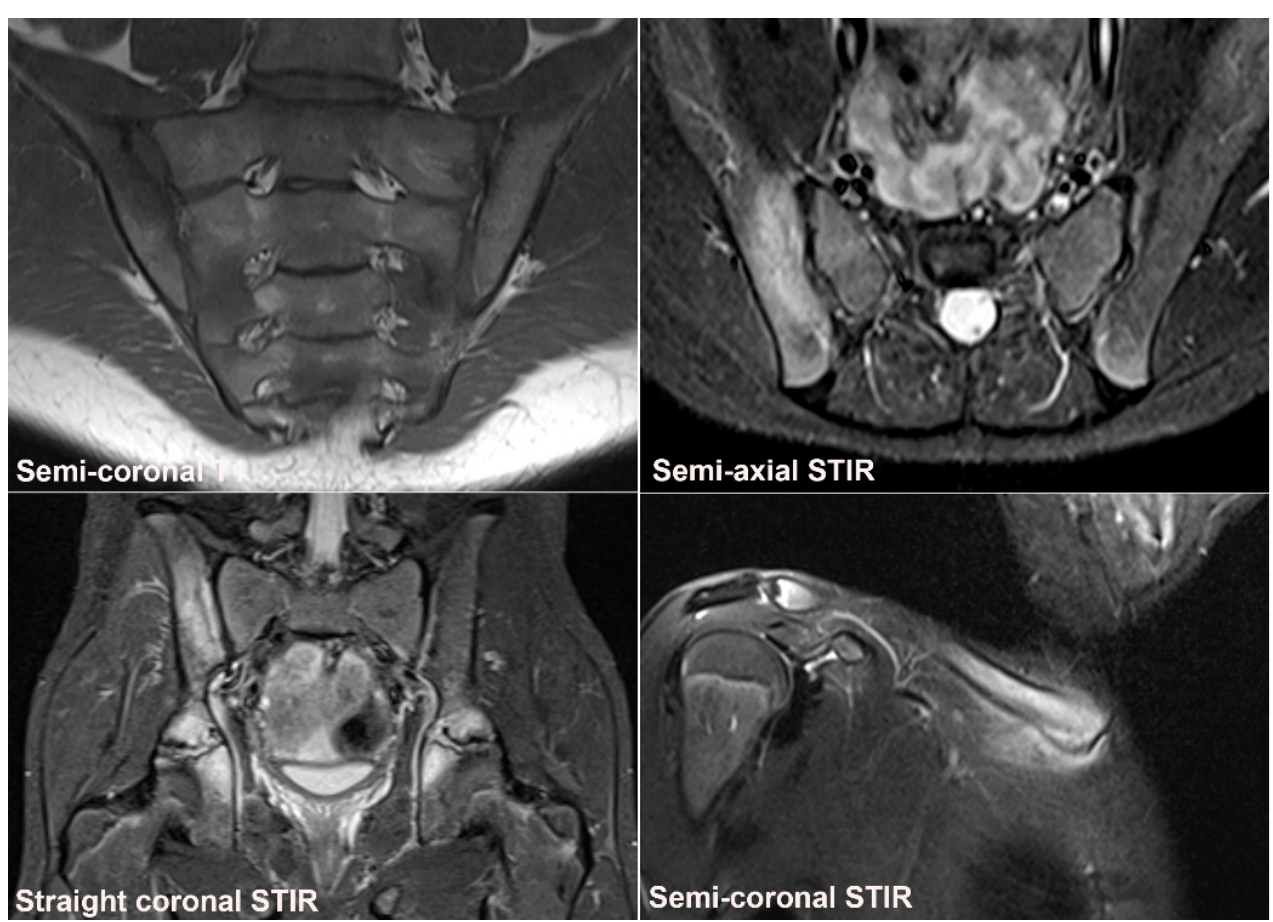
Figure 29. CNO in childhood ( CRMO —chronic recurrent multifocal osteomyelitis). MRI in a 14- year-old boy with recurrent hip and ACW pain for 9 months, semi-coronal T1, and semi-axial STIR of the SIJs, straight coronal STIR of the pelvis, and semi-coronal STIR of the right clavicle showing pronounced BME in the right iliac bone adjacent to the SIJ, but no pathological BME in the sacrum. In addition, pronounced BME around the ischiopubic synchondroses and in the right clavicle.